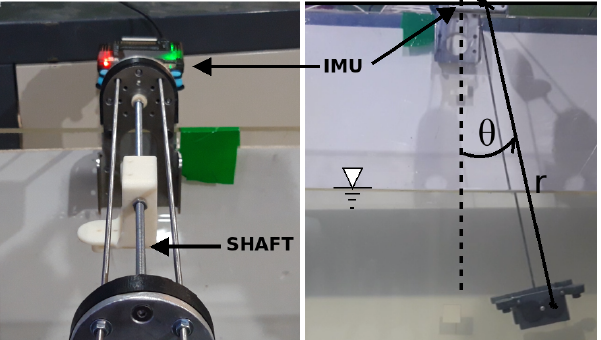
Figure 10. Diagram of the free decay pendulum test, where θ is the angle with respect to the stability point and L is the length of the